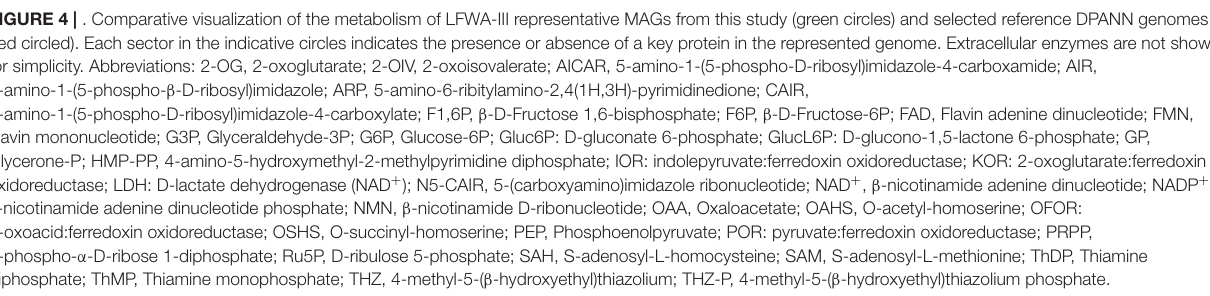
annotated as a VIT family protein (TCDB 2.A.89.1.9), often involved in iron homeostasis. Ca 2 + /Na + and H + /K +